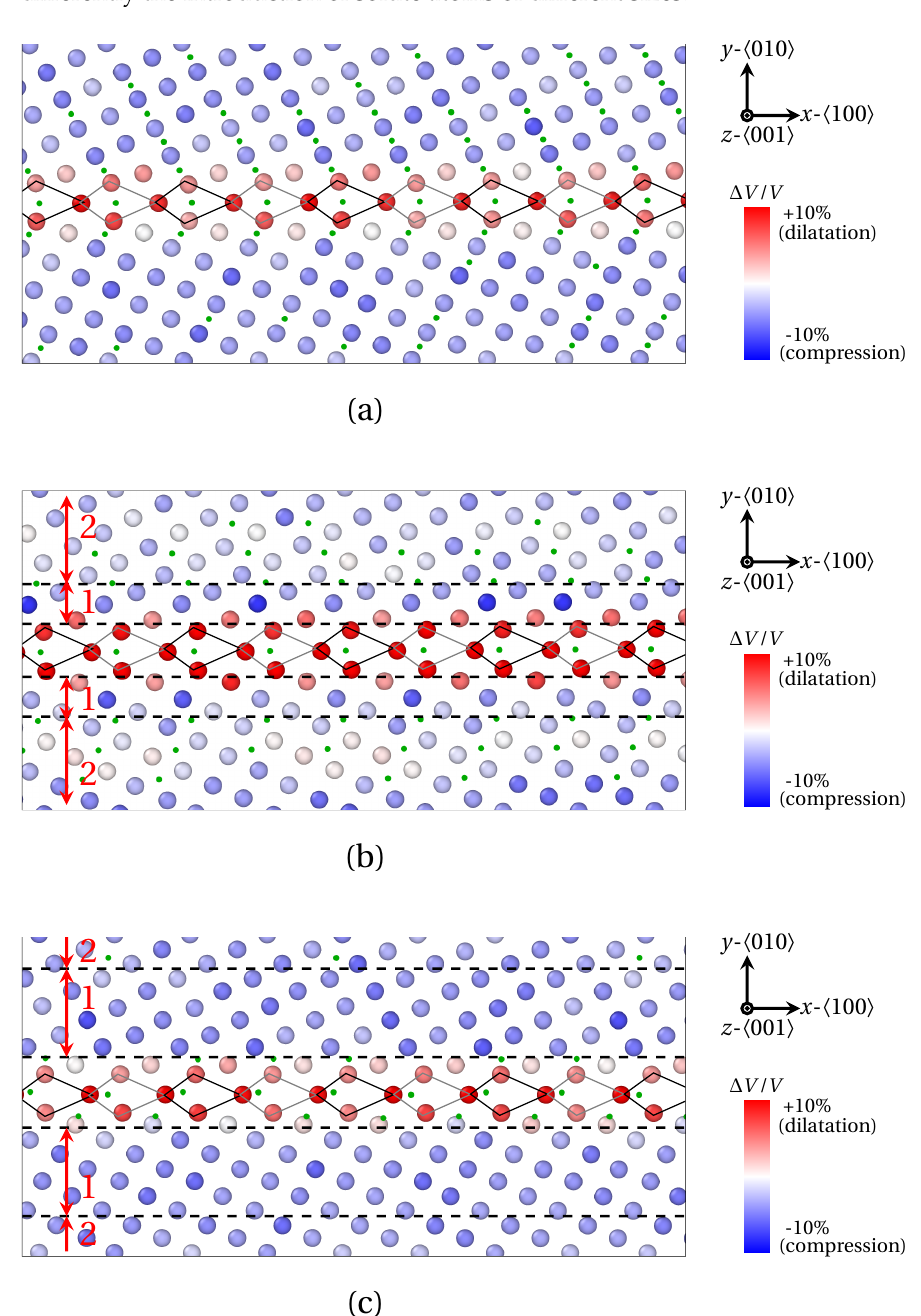
Figure 8. Influence of the volume per atom (Voronoi analysis) on the segregation of X 1 ( a ) X 2 ( b ) and X 3 ( c ) solute atoms at Σ 5 ( 310 ) ( θ = 36.87 ◦ ). X 1 atoms are spotted by green dots. The depleted (over-compressed) and segregated (less compressed) areas are delineated by dashed black lines, and referred to as zones 1 and 2 in ( b , c